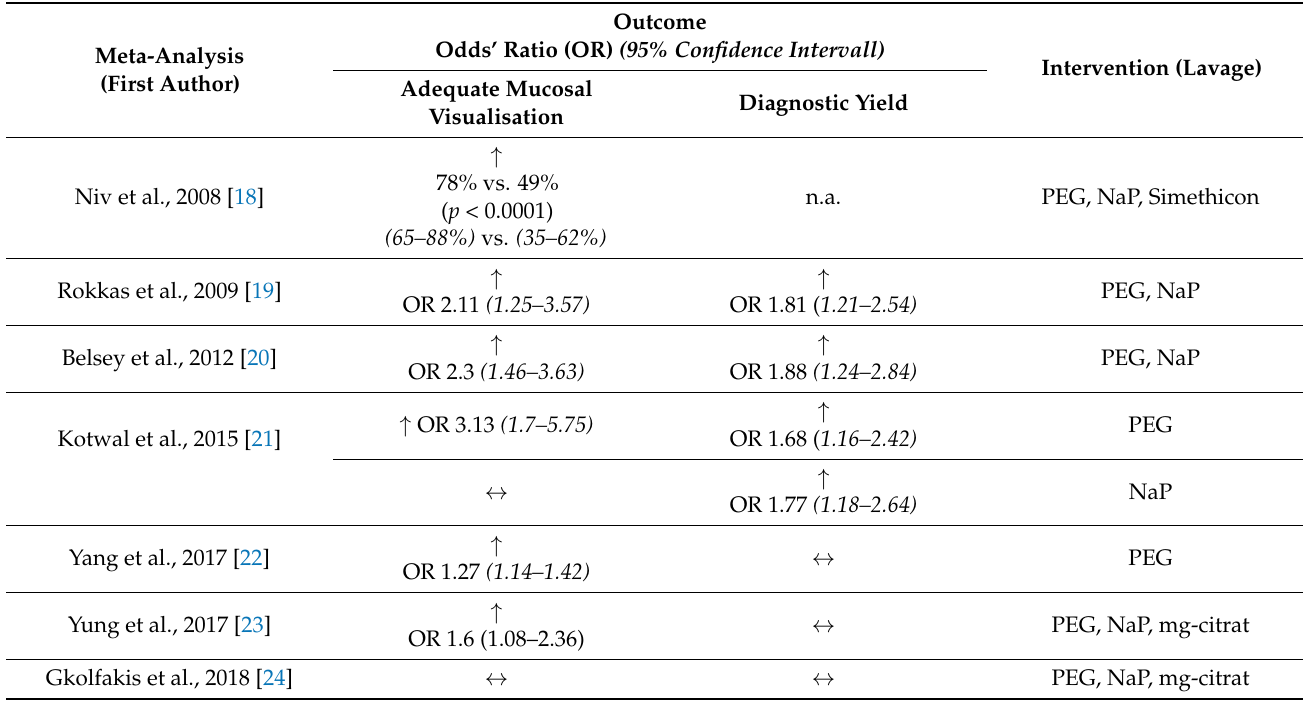
Table 1. Meta-analyses of studies on lavage before small bowel capsule endoscopy versus clear liquids the day before.